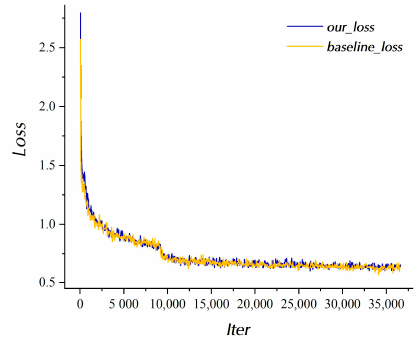
Figure 10. Comparison of losses during